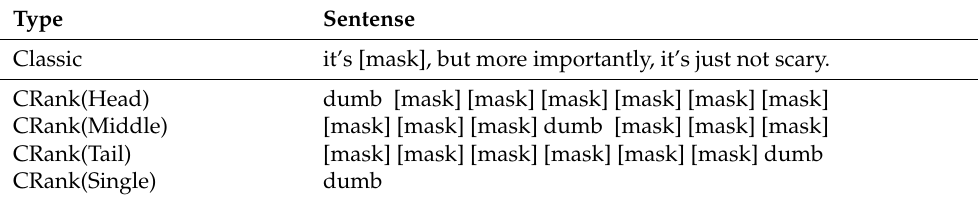
Table 3. Scoring ‘dumb’ with classic and CRank. The original sentence is “it’s dumb, but more importantly, it’s just not